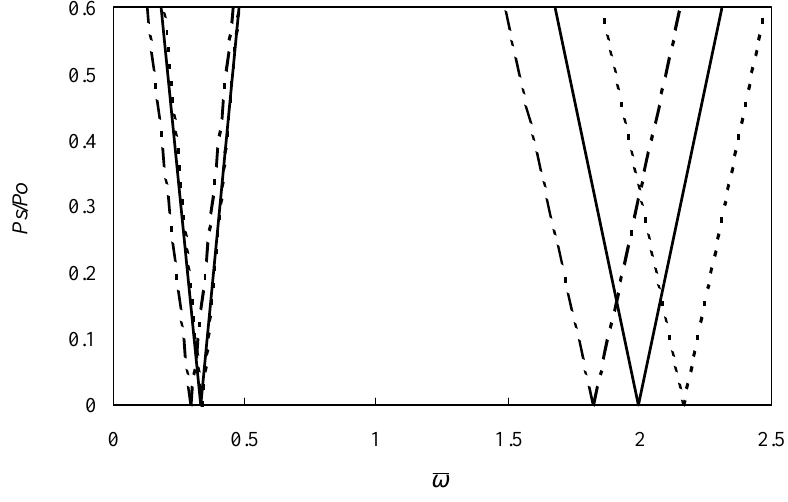
Fig. 9. First two instability regions for a rotating beam with double cracks, L = 1 . 0 m, Ω = 1 and a/h = 0 . 5 . ‘-.-.-’ x cmean = 0 . 25 , ‘–’ x cmean = 0 . 5 , ‘- - -’ x cmean = 0 . 75